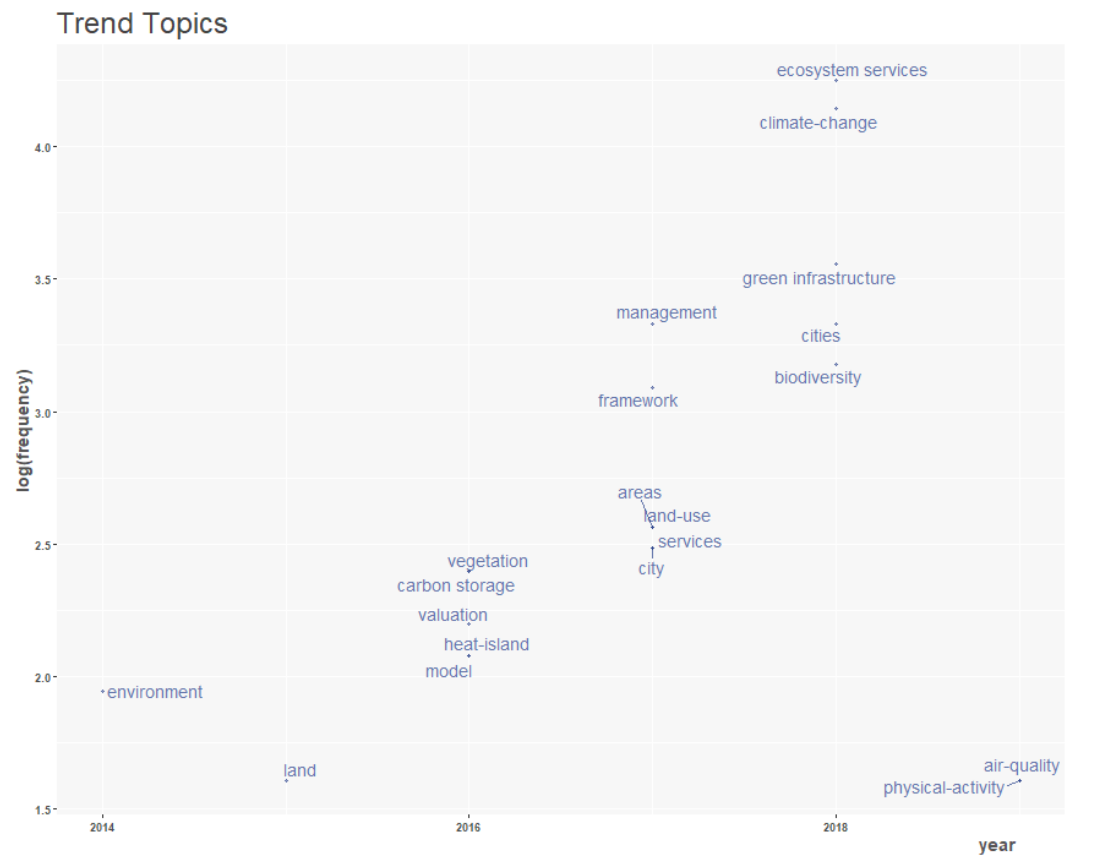
Figure 12. Trending Topics by Keywords Plus. Source: Biblioshiny. Own compilation.